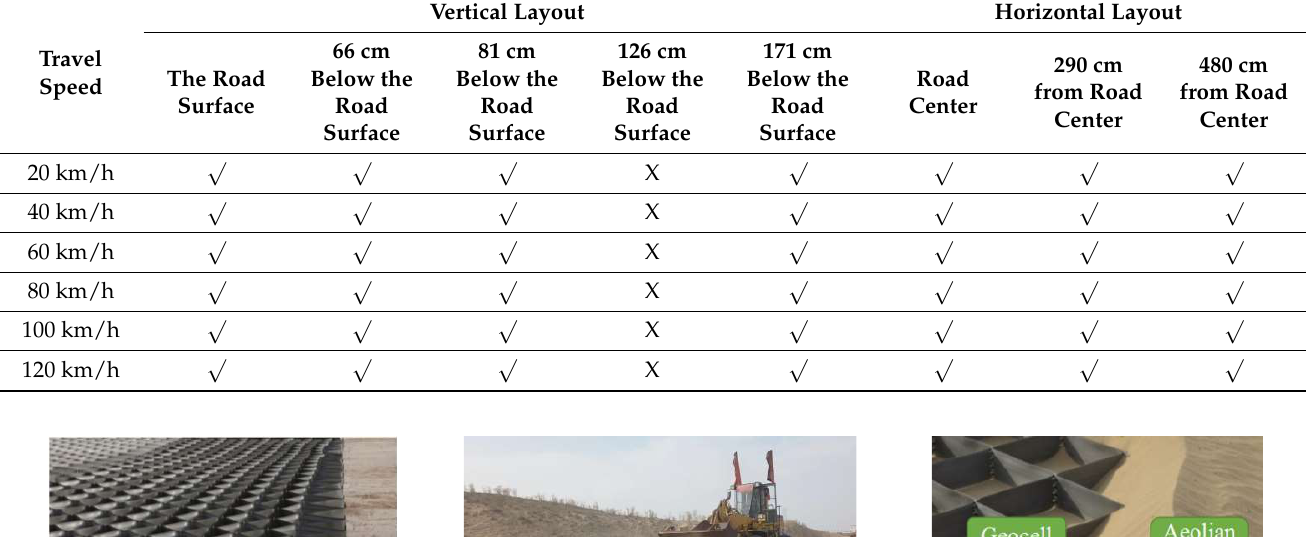
Table 3. Scheme 2 test location and working condition table.